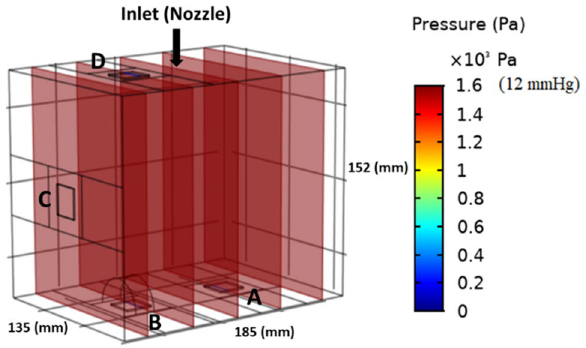
Figure 5. CFD simulation result of CO 2 gas filling of the box model to a pressure of 12